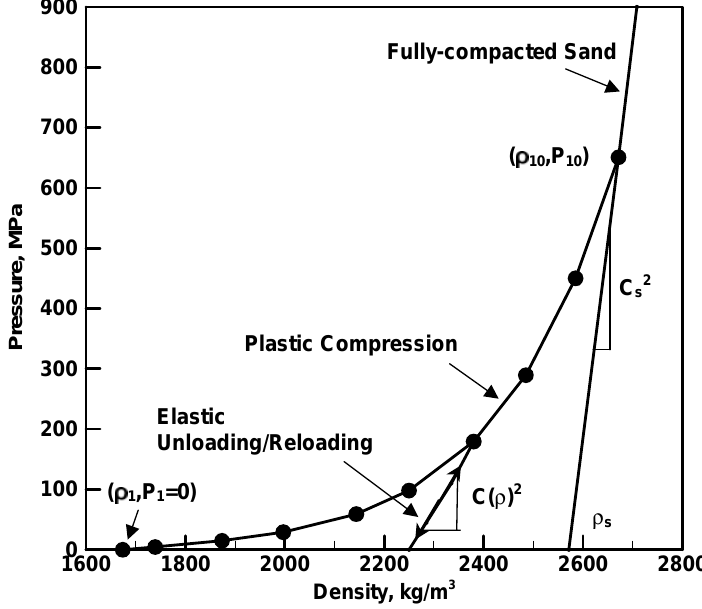
Fig. 1. Pressure vs. density relations for dry sand as defined in the AUTODYN materials library